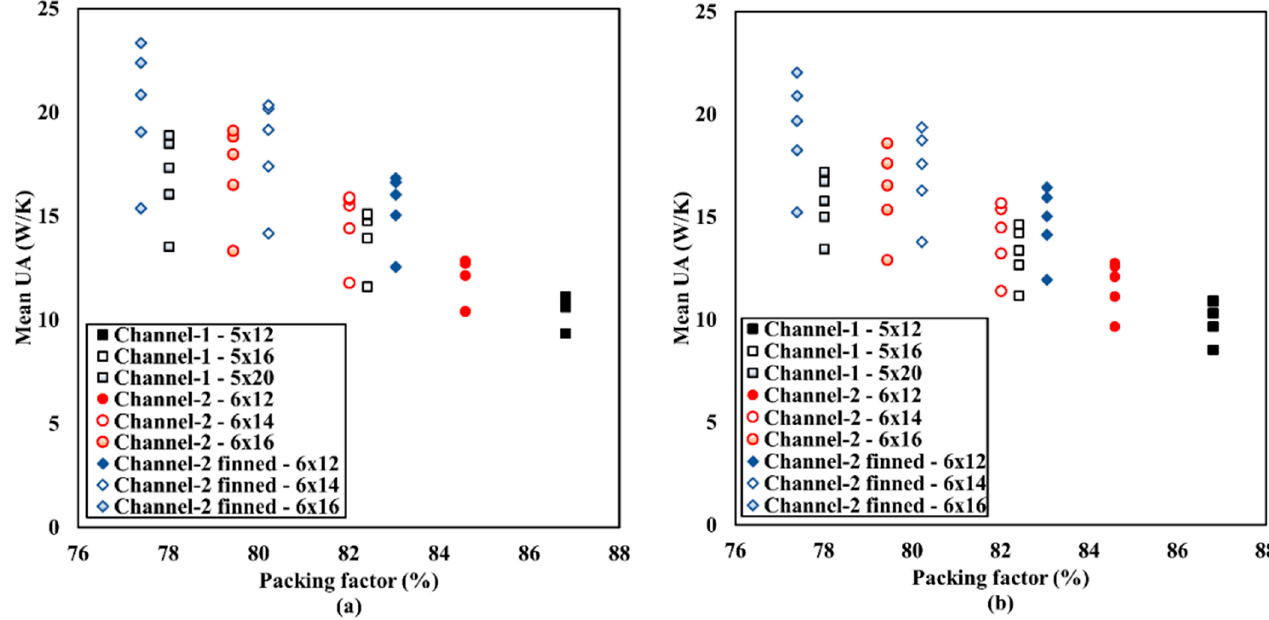
Figure 10. Mean UA values for the range of the simulated flow rate as functions of the PCM packing factor: ( a ) melting- Tin = 30 °C, ( b ) solidification-Tin = 15 °C.